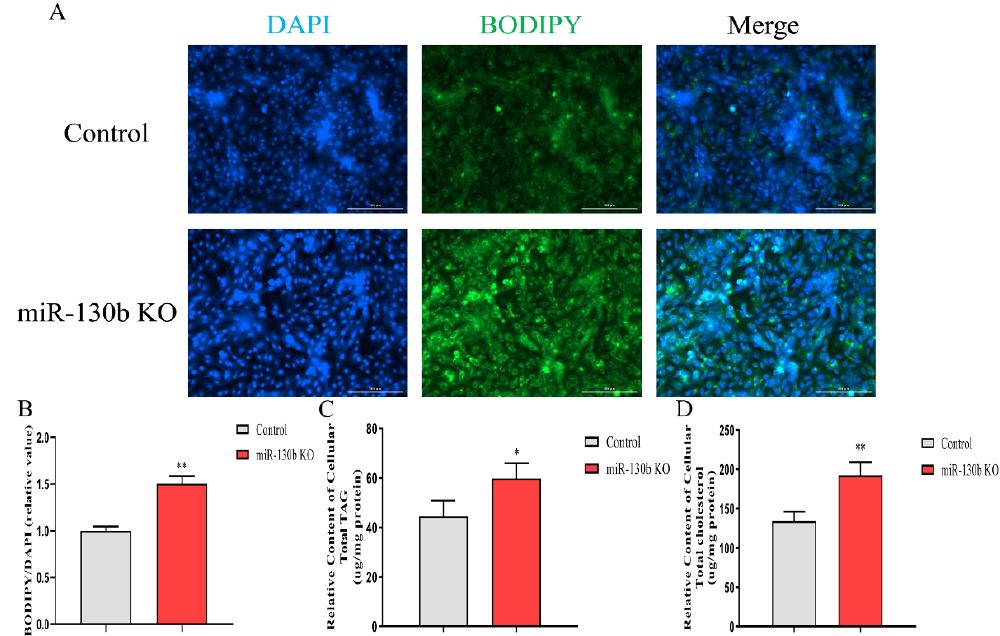
Figure 3. Knockout of miR-130b promotes cellular lipid droplets, TAG and cholesterol accumulation. Detection of lipid droplets ( A , B ), TAG ( C ), and cholesterol ( D ) contents in miR-130b KO and control cells. Data are presented as mean ± SEM. p < 0.05 and p < 0.01 are indicated as * and **. Table 1. Effects of miR-130b Knockout on Fatty Acid Composition in GMEC 1 .